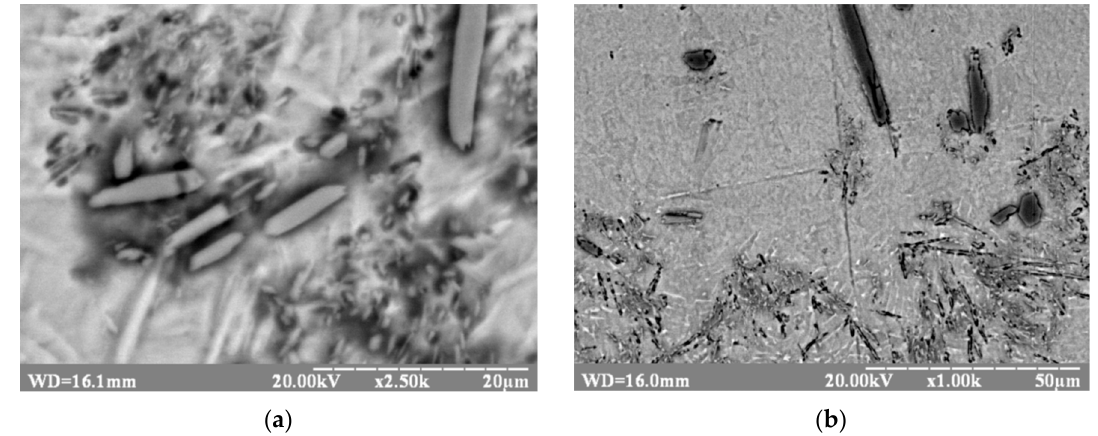
Figure 13. Boron-containing inclusions in the Ti-TiB welded seam zone of (Ti-TiB)–T110 welded joint: ( a ) after electron-beam welding (number 6 series sample); ( b ) after electron-beam welding and subsequent annealing at 850 °С (number 8 series sample).